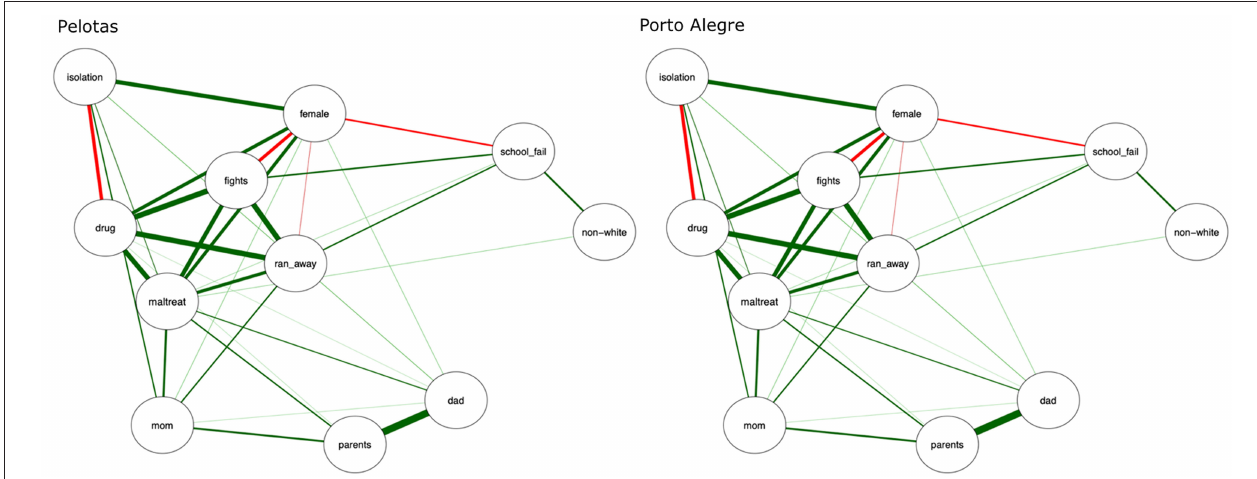
FIGURE 6 | Network analysis of variables that are part of the IDEA-RS by cohort. Structure of Pelotas and Porto Alegre Identifying Depression Early in Adolescence risk score (IDEA-RS) networks with 11 nodes, each representing one of the risk score’s variables. The green linkage lines between variables represent positive correlations. The red linkage lines represent negative correlations. Thicker lines represent greater strength of the correlation, which is based on the weighted network analysis. non-white, non-white skin color; drug, any drug use; school_fail, history of school failure; isolation, social isolation; fights, fight involvement; mom, relationship with mother; dad, relationship with father; parents, relationship between parents; maltreat, childhood maltreatment; ran_away, ran away from home.